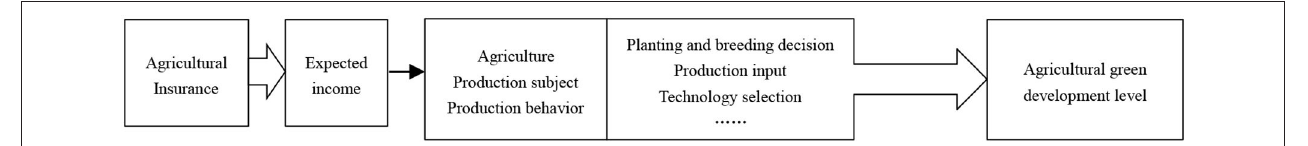
FIGURE 1 | The impact mechanism of agricultural insurance and agricultural green development level.